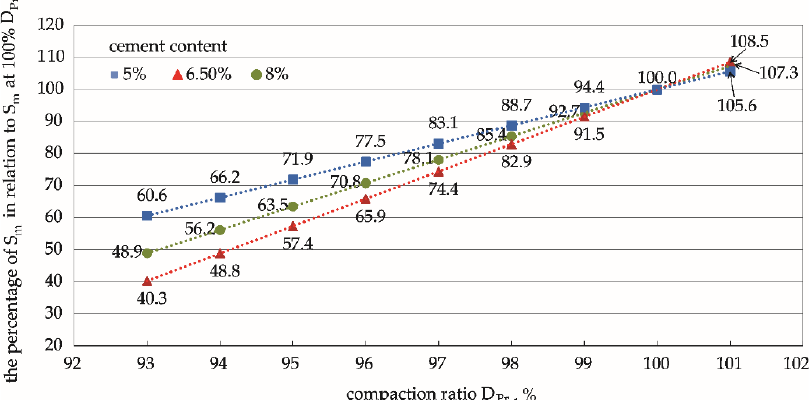
Figure 13. Corresponding relationships between the percentage of dynamic stiffness modulus, 𝑆 𝑚 , under different compaction ratios in relation to 𝑆 𝑚 at 100% 𝐷 𝑃𝑟 . Cement content: 5%, 6.5%, 8% .